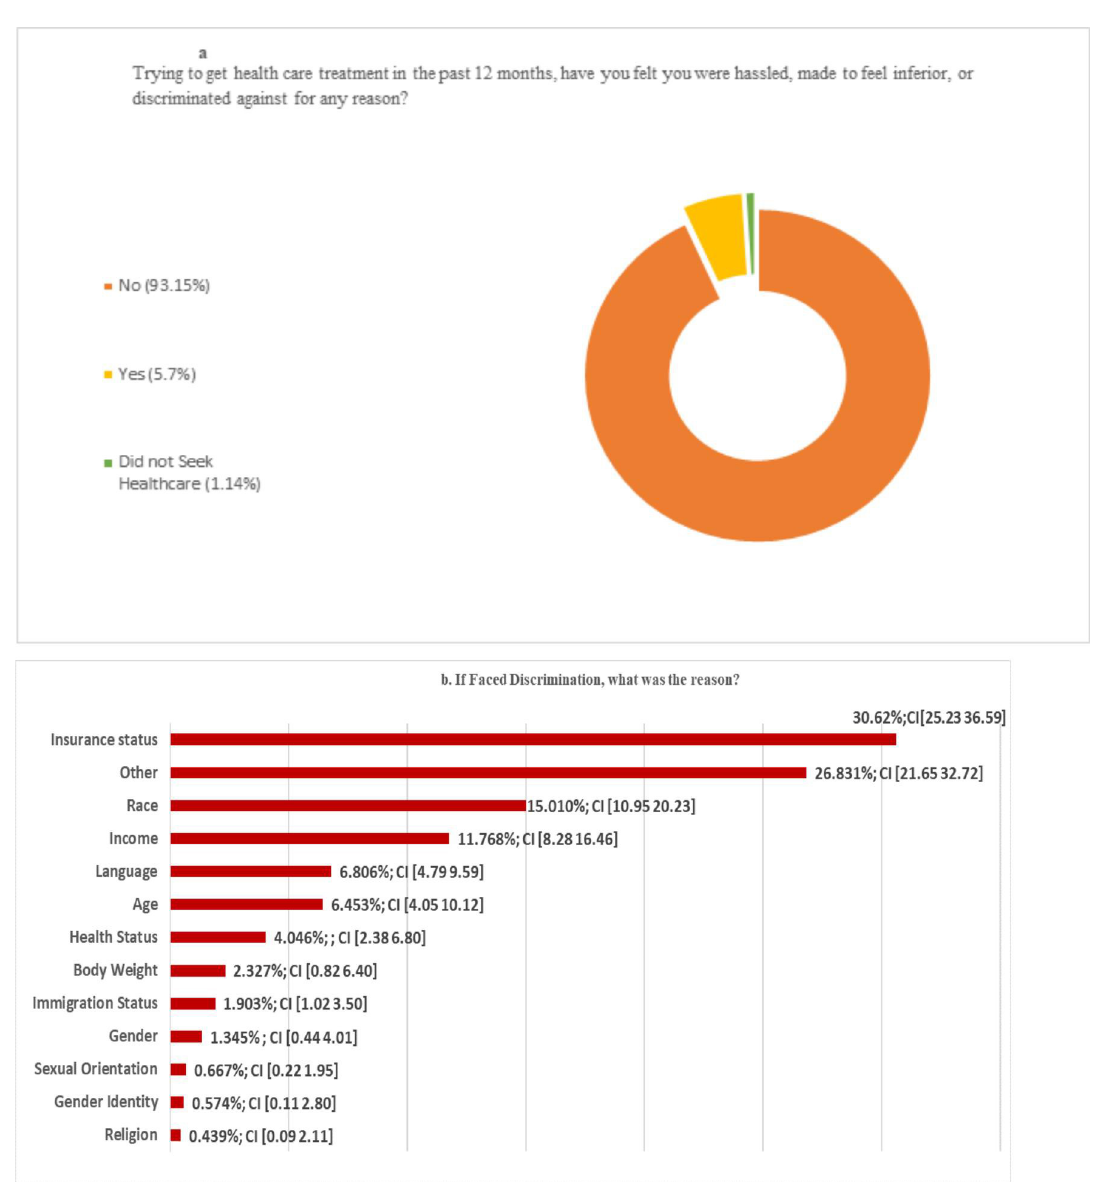
Fig 1. Prevalence and type of discrimination in health care. (A) Trying to get health care treatment in the past 12 months, have you felt you were hassled, made to feel inferior, or discriminated against for any reason? (B) If experienced discrimination, what was the